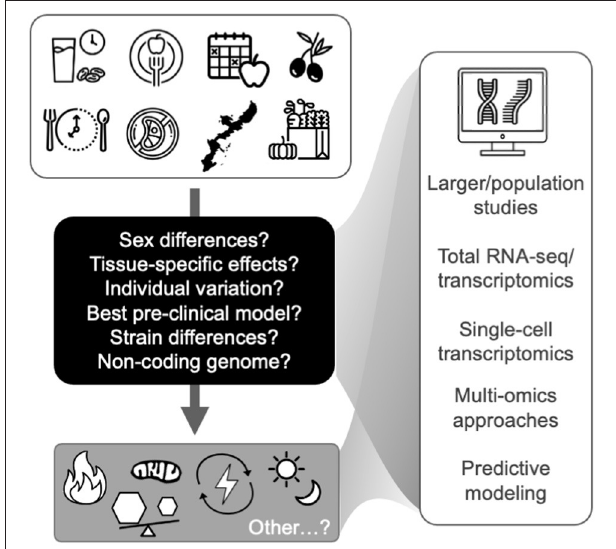
FIGURE 2 | Future studies are needed to identify key transcriptomic modules that relate to the hallmarks of aging (bottom gray box) and represent targets for healthy aging in humans. Future directions and key issues (shown in the black box and at right) in transcriptomic studies of healthspan-promoting nutritional interventions are also noted. Icons from nounproject.com under Creative Commons